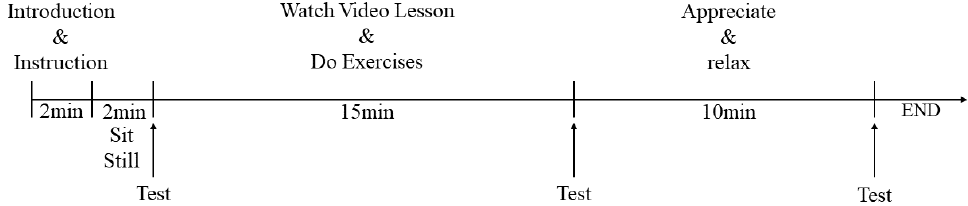
Figure 2. The procedure of the